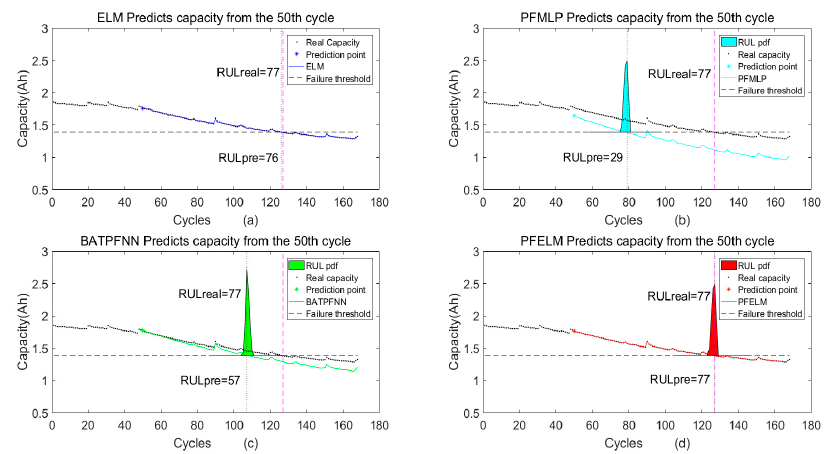
Figure 5. Capacity prediction error from the first cycle.